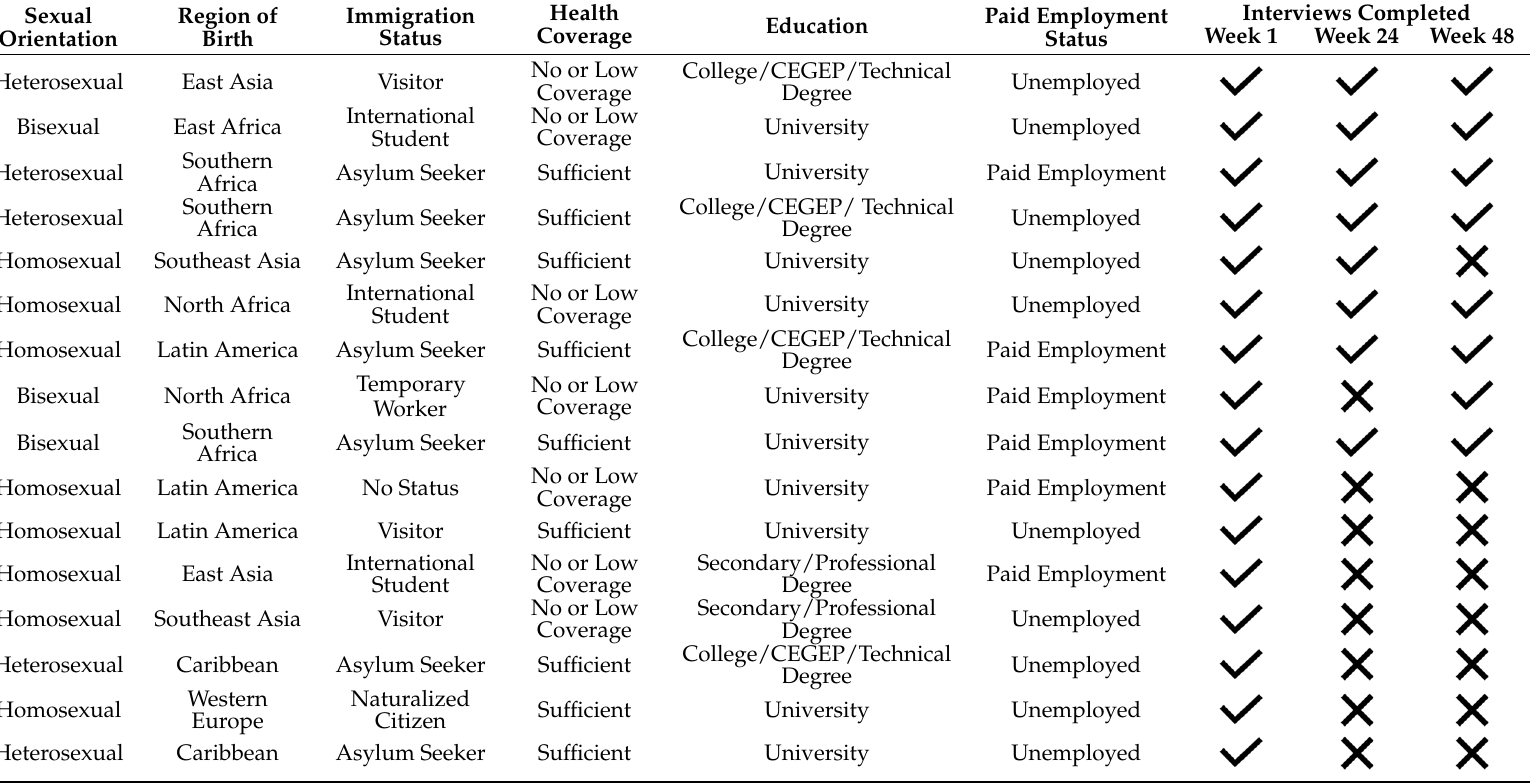
Table 1. Sociodemographics at study enrollment of interviewed